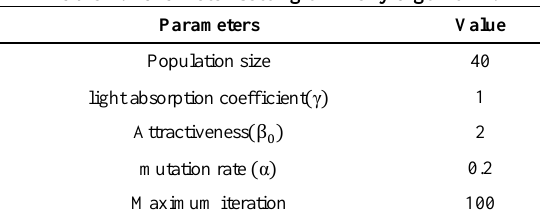
Table 2. Parameter setting of firefly algorithm.